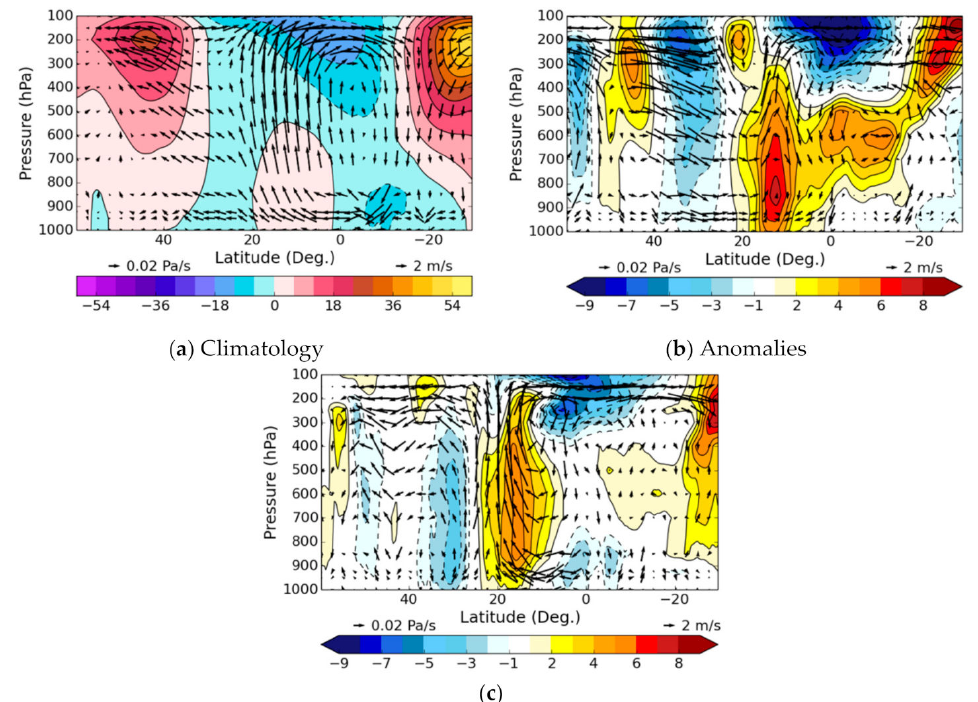
Figure 3. Zonal U wind (contour and shading) and meridional-omega wind vector for ( a ) climatology (August monthly mean from 1981 to 2010), ( b ) anomalies for August 2016 and ( c ) biases for the 7-day forecast in the control experiment (CTL) experiment averaged during August 2016. All values are averaged 120 ◦ E–140 ◦